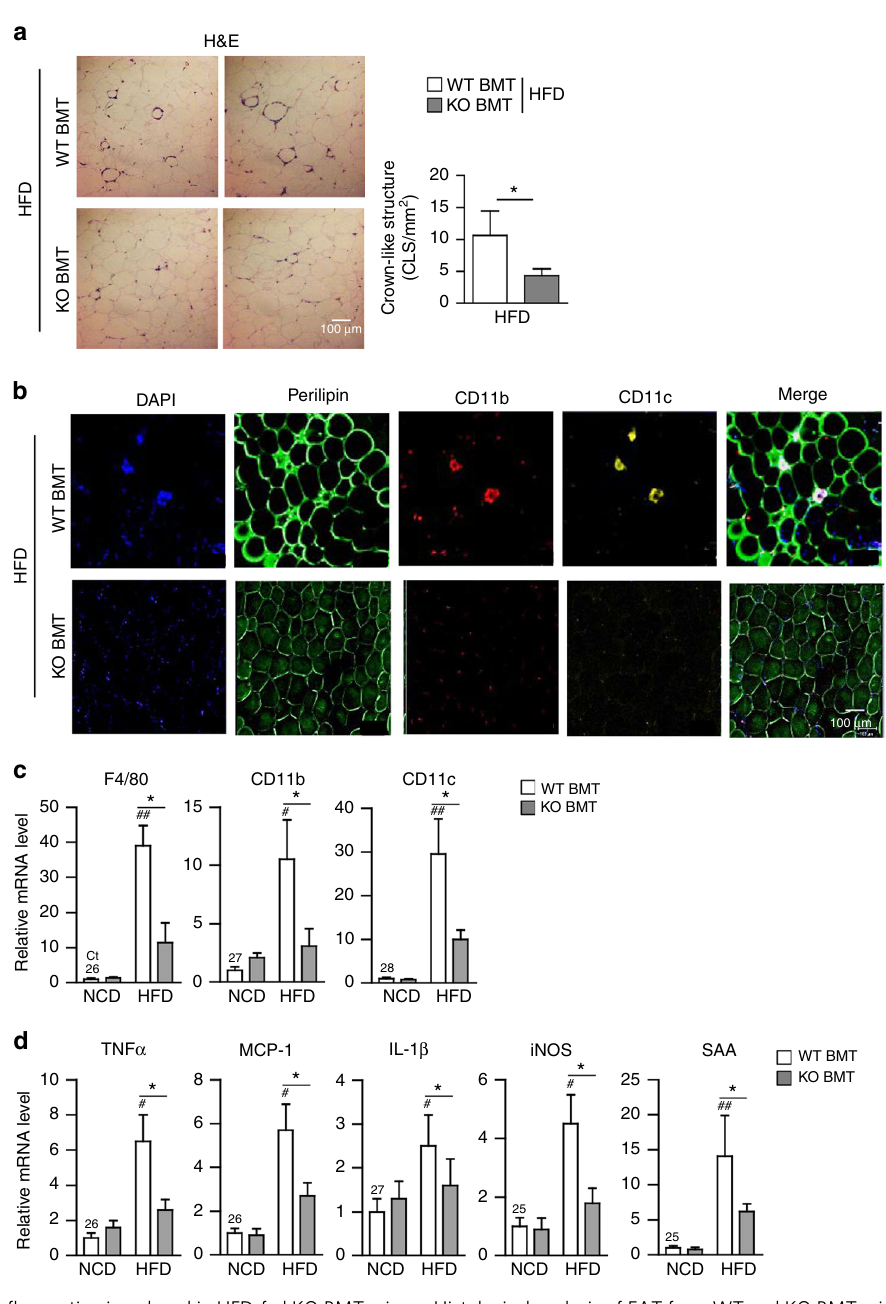
Fig. 8 Adipose tissue in fl ammation is reduced in HFD-fed KO BMT mice. a Histological analysis of EAT from WT and KO BMT mice using H&E staining. b Whole-mount immunohistochemistry of the nucleus (blue), CD11b (red), and CD11c (yellow). Immune cell markers in EATs from WT and KO BMT mice. c , d Relative mRNA levels of macrophage ( c ) and pro-in fl ammatory ( d ) markers in EATs from WT and KO BMT mice. Each mRNA level was normalized to cyclophilin mRNA. Data represent mean ± SD. # P < 0.05 vs. HFD; ## P < 0.01 vs. HFD; * P < 0.05, Student ’ s t